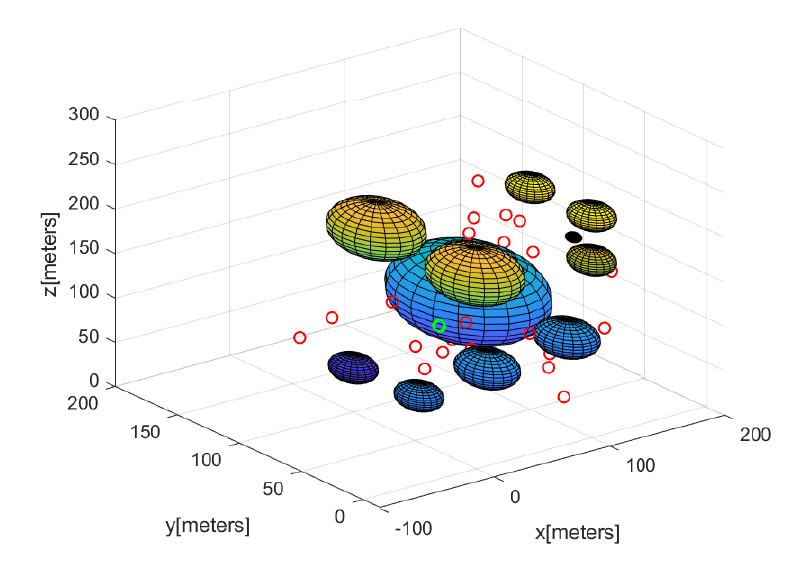
Figure 13. Every UUV’s final position after the rendezvous is completed (the waypoint approach is utilized). A total of 25 broken UUVs are illustrated with red circles. All healthy UUVs (green circles in the figure) rendezvous at the root. Obstacles are plotted with